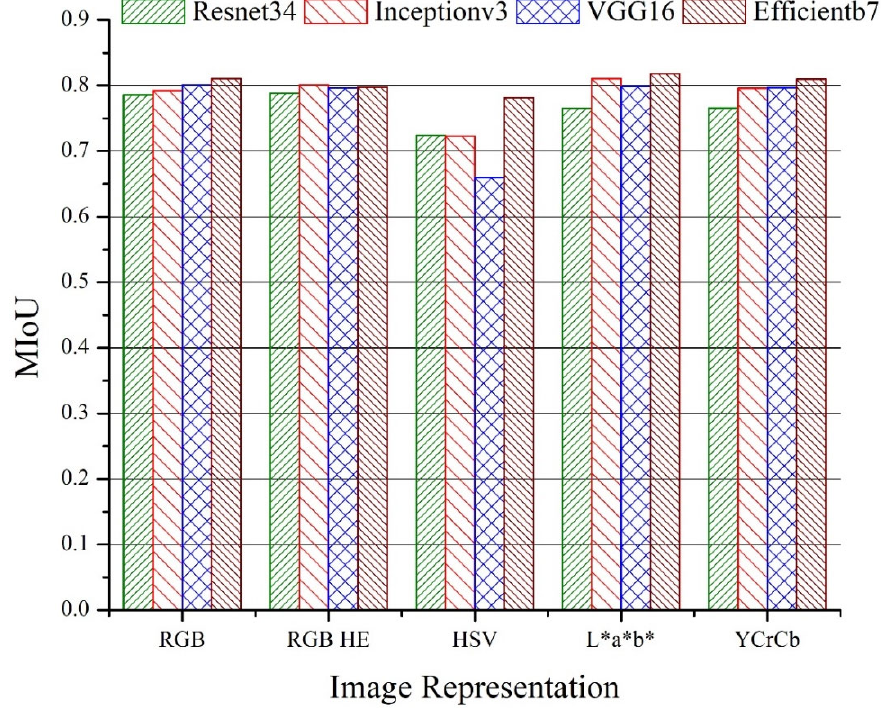
Figure 7. Mean intersection of union (MIoU) for U ‐ Net models with different backbones and image color representations for test data.